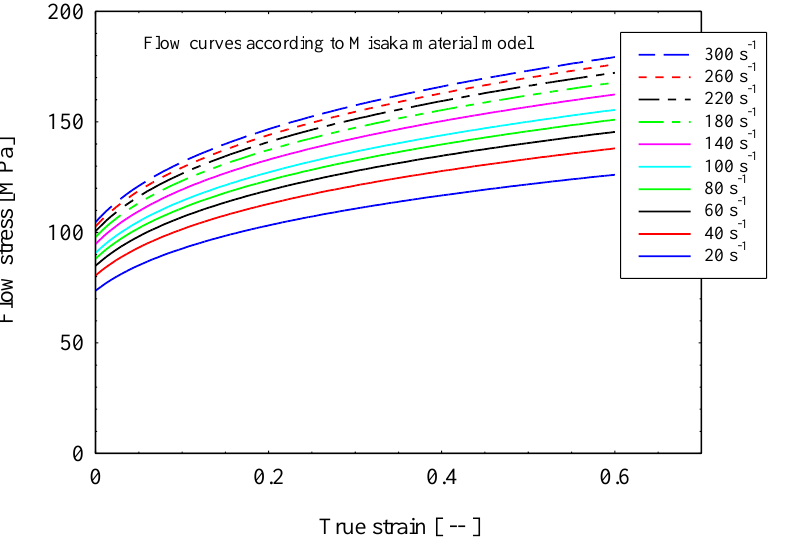
Figure 5. Flow curves according to Misaka’s material model as a function of strain and strain rate (20 – 300 s −1 ) at a temperature of 1100 °C.